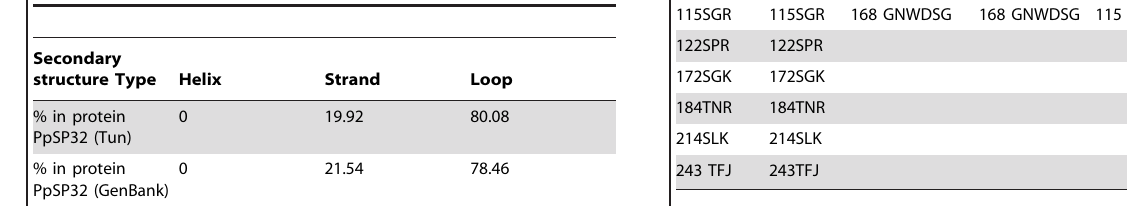
Table 1. Percentage of secondary structure the Tunisian PpSP32 compared to PpSP32 from Genbank.